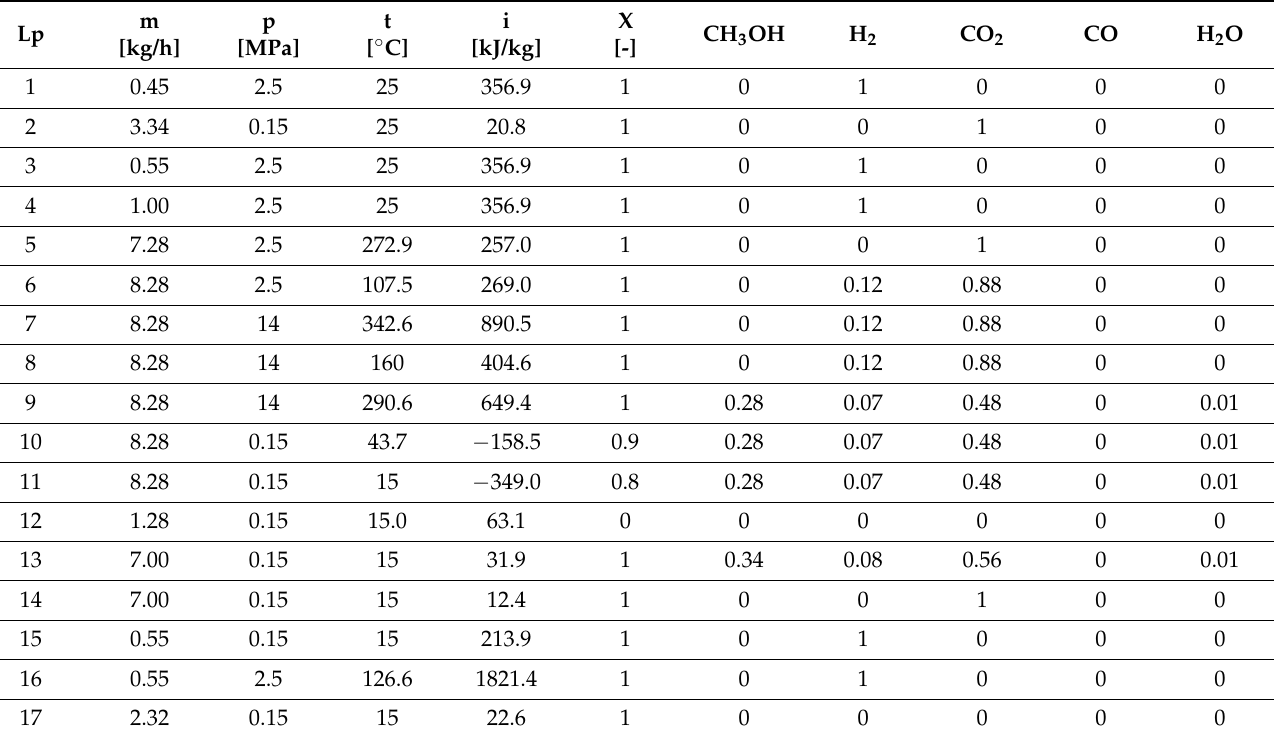
Table 2. Examples of the analysis results obtained for the pressure of 14 MPa and the temperature of 160 ◦ C at the inlet to the reactor in point